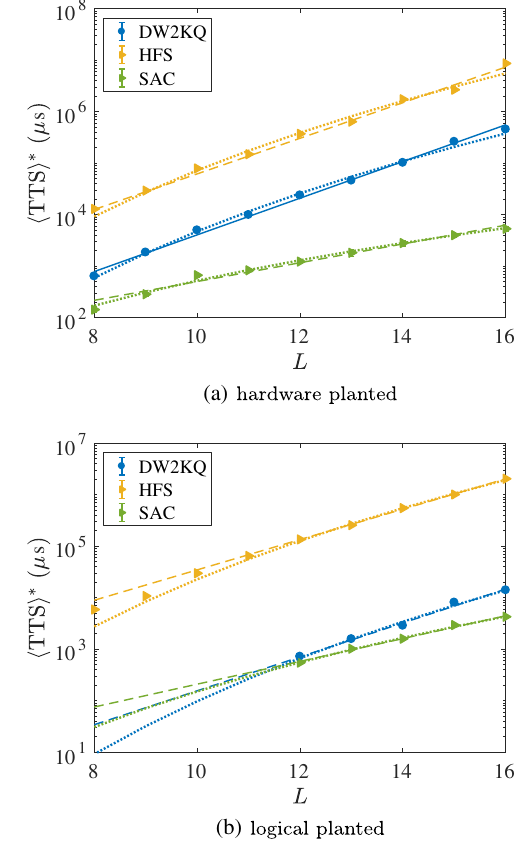
FIG. 20. Scaling of the median optimal TTS with problem size for DW2KQ versus HFS and SAC. The data points represent the DW2KQ (blue circles), HFS (yellow left triangle), and SAC (green right triangle). The dashed and dotted curves correspond, respectively, to exponential and polynomial best fits with parameters given in Table III. (a) Hardware-planted instances. (b) Logical-planted instances. The data symbols obscure the error bars, representing the 95% confidence interval for each optimal TTS data point [computed from the fit of ln h TTS i to a quadratic function as explained in Appendix K]. Table III. We find that for the logical-planted instances, the HFS algorithm scales better than the DW2KQ, while for the hardware-planted instances, the scaling of the two is statistically indistinguishable.